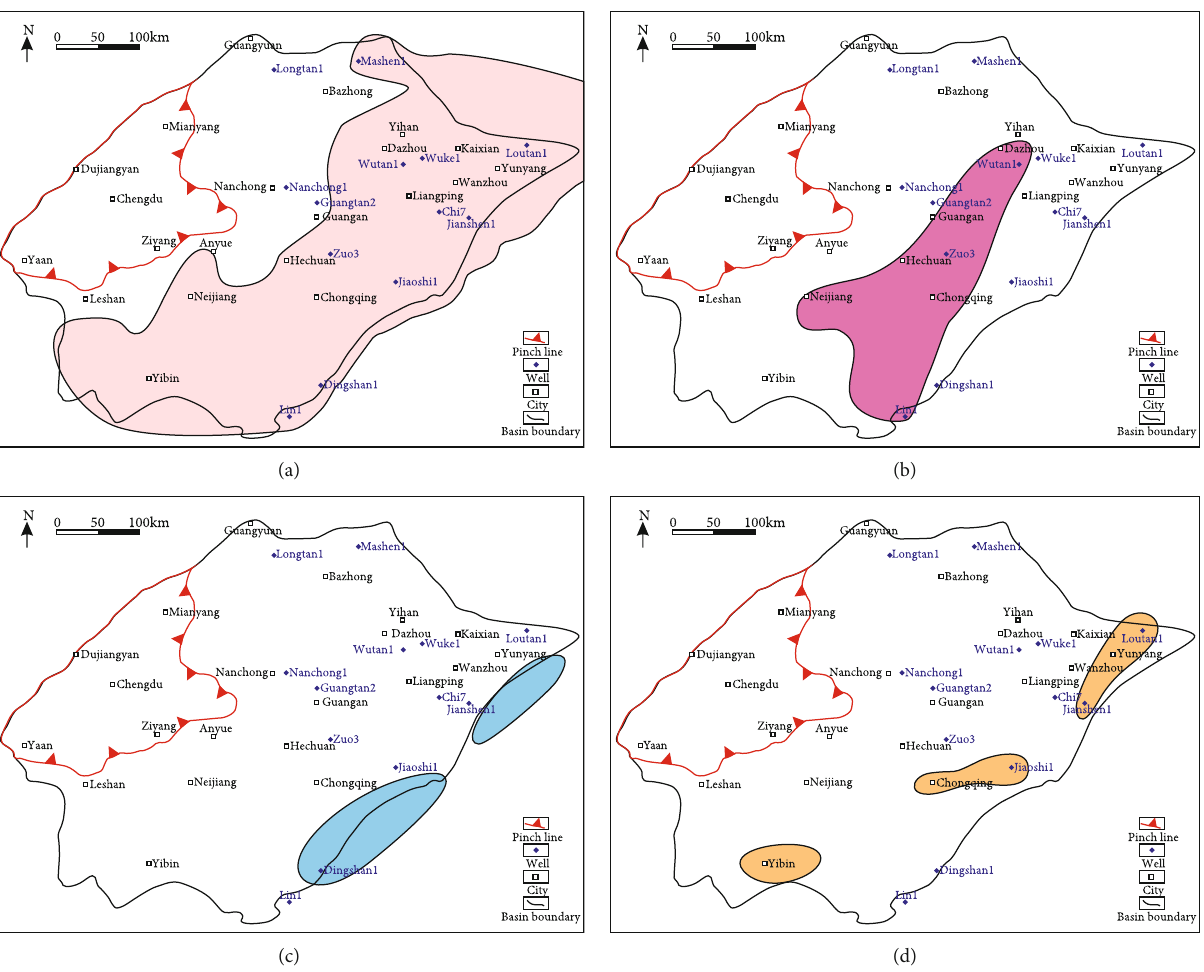
Figure 8: Distribution range of DEPS. (a) Interbedding of dolostone and evaporite; (b) evaporite overlying thick dolostone; (c) thick dolostone mixed with thin evaporite; (d) thick evaporite mixed with thin